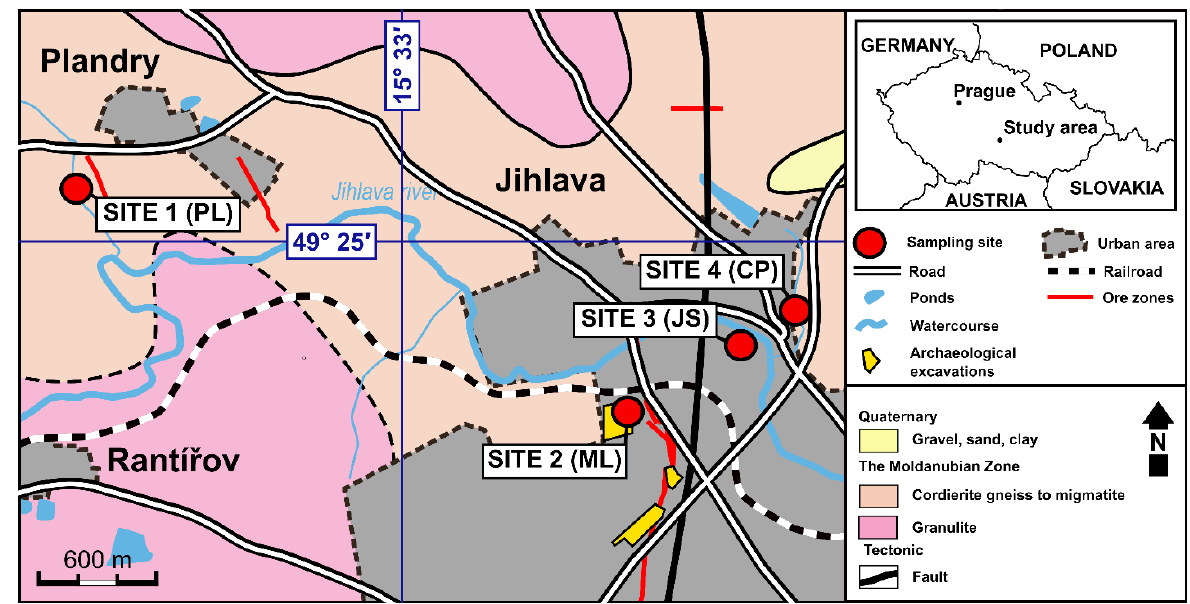
Figure 1. Localization of sampling sites. Archaeological excavations and outcropping ore minerali- zation are projected according to